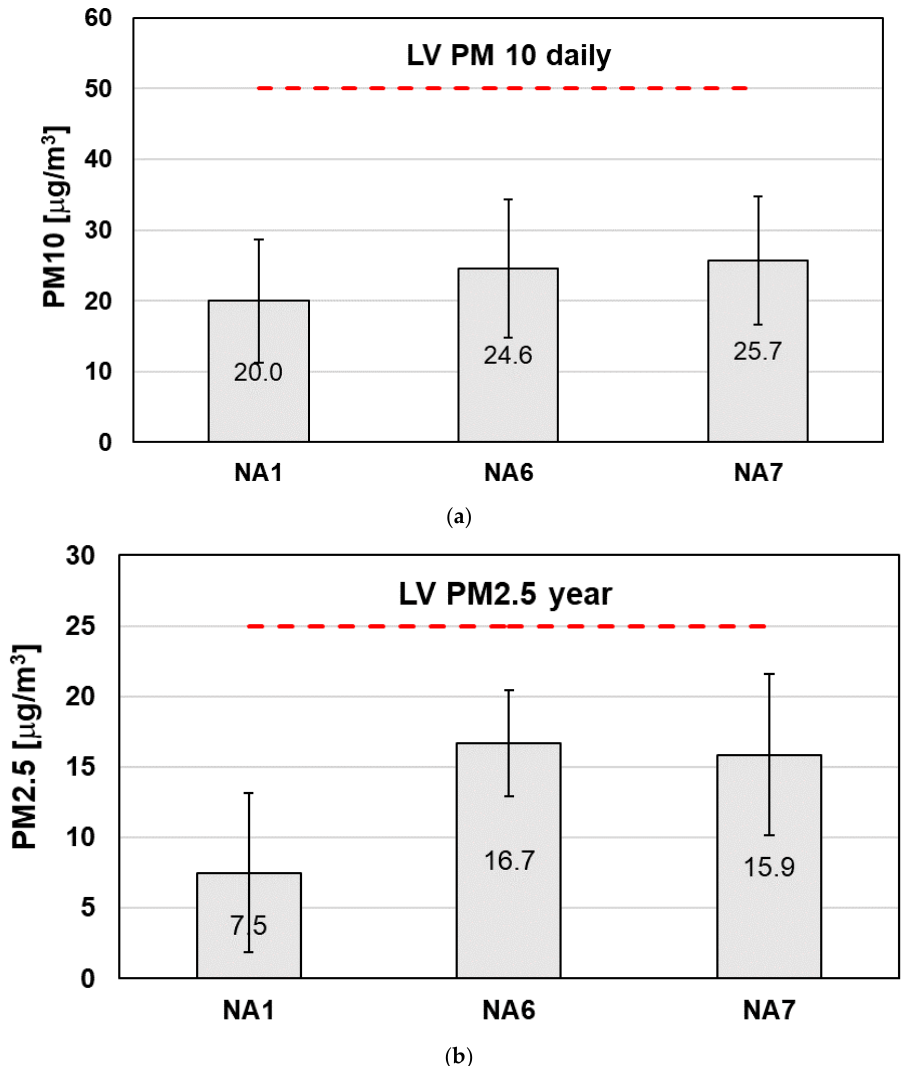
Figure 2. Average PM 10 ( a ) and PM 2.5 ( b ) concentration measured at fixed stations during the monitoring campaign. Red lines represent limit values (LV) in European countries.